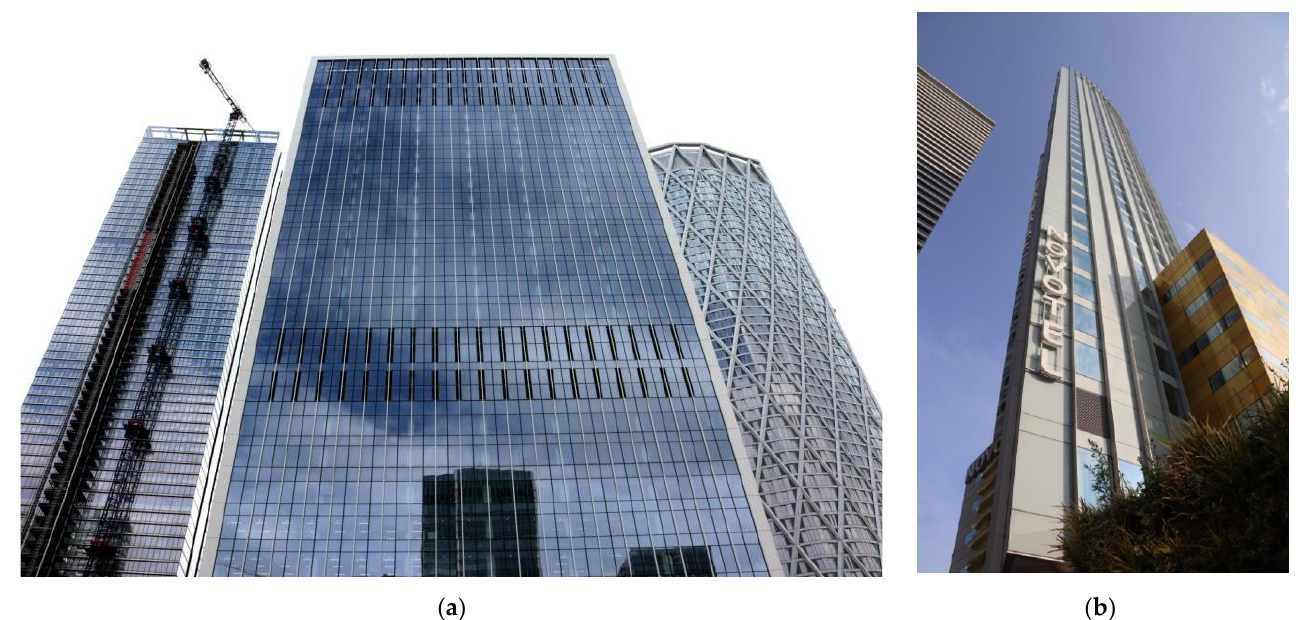
Figure 8. ( a ) Similarities between architectural design of residential and office towers in the Isle of Dogs; from the left: Landmark Pinnacle, 1 Bank Street, Newfoundland (2020); ( b ) Structurally colourful Novotel (2021).